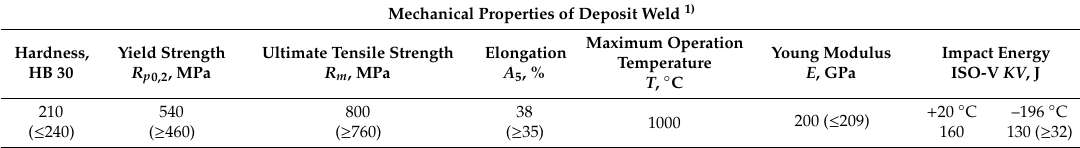
Table 5. Mechanical properties of Böhler L625 (EN NiCr22Mo9Nb) powder deposit